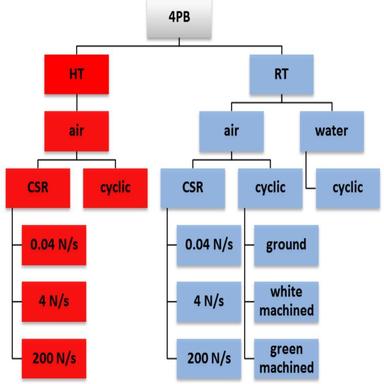
Chart listing the tests carried out on bend bars in a four-point bending configuration.